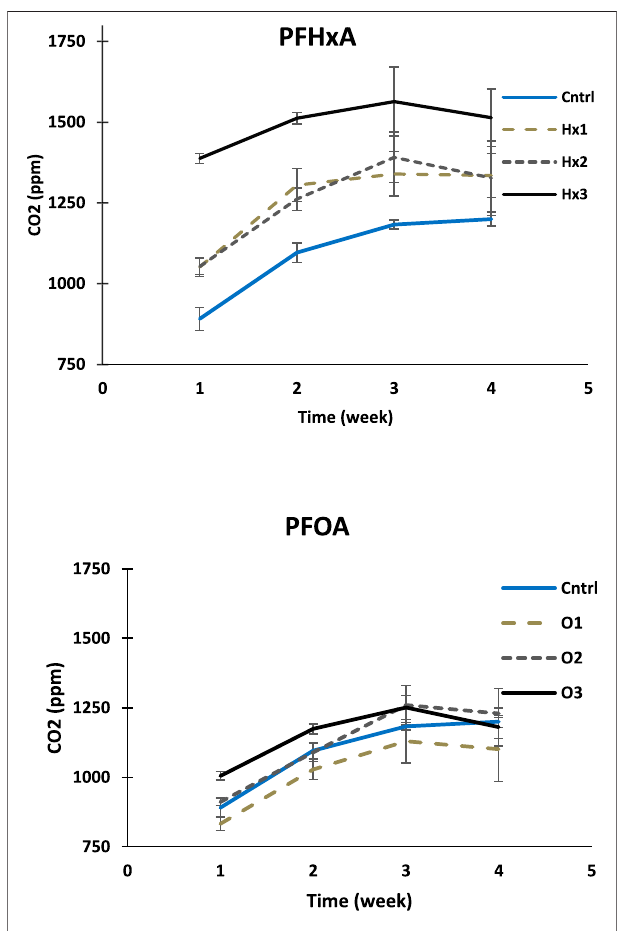
FIGURE 5 | The CO 2 concentrations growth curves are shown as each measuring week mean CO 2 ppm-levels for PFHxA and PFOA treatments compared to control (the error bars represent SDs; n = 4). Note that both fi gures have the same scaling in the y-axis starting from 750 ppm.